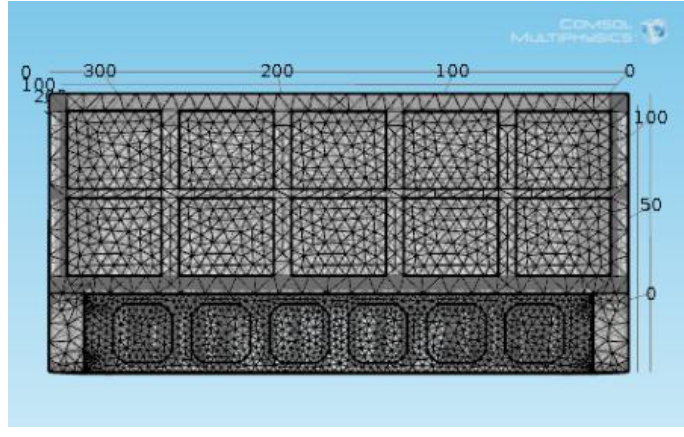
Figure 8. Finite-element mesh model of the system.